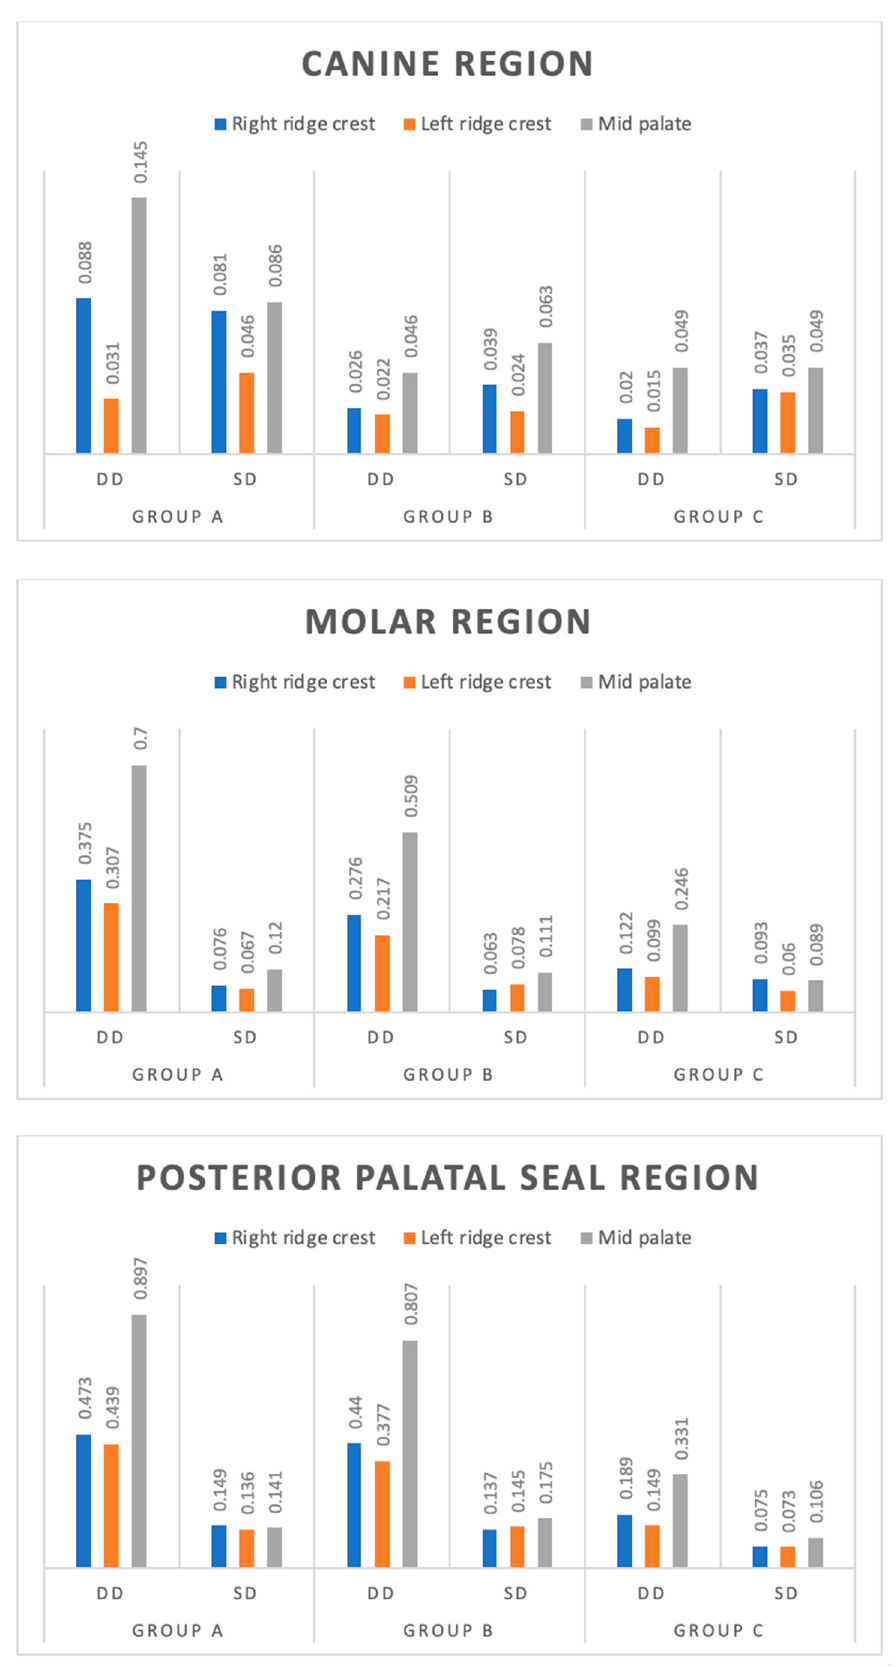
Figure 7. Mean dimensional discrepancy (mm) of three groups at three sites of canine, Molar and Posterior Palatal region at 12 h. Dimensional discrepancy (DD); Standard deviation (SD).